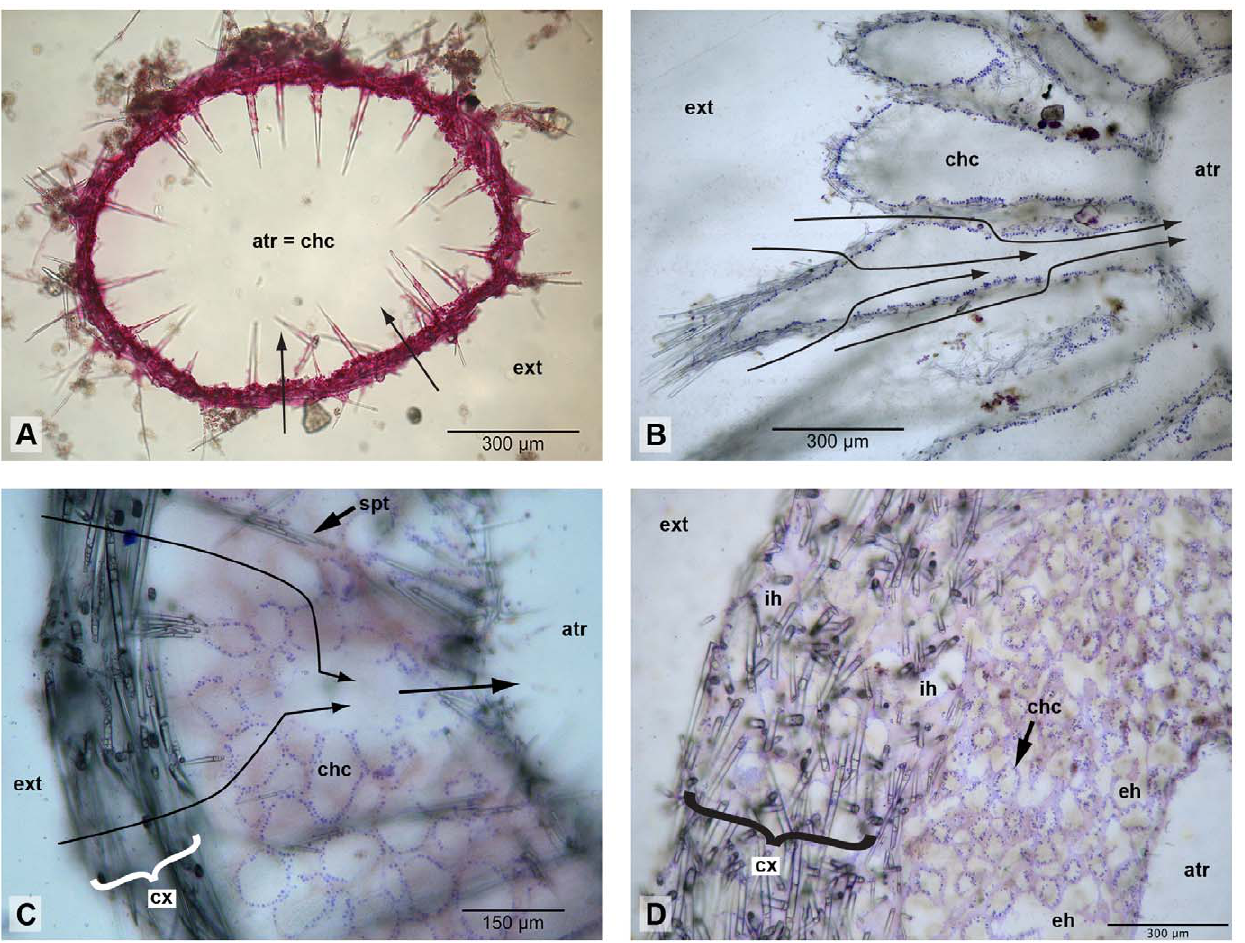
Figure 1. Different organizations of the aquiferous system in Calcarea. A: asconoid ( Soleneiscus radovani ); B: syconoid ( Sycon coronatum , from Helgoland, Germany); C: sylleibid ( Grantiopsis cylindrica ); D: leuconoid ( Leucettusa sp. 1). Thin arrows illustrate the direction of water flow in A, B and C. atr=atrium; chc=choanocyte chambers; cx=cortex; eh=exhalant channel; ext: exterior of the sponge; ih=inhalant channel; spt=spicule tract of modified triactines.